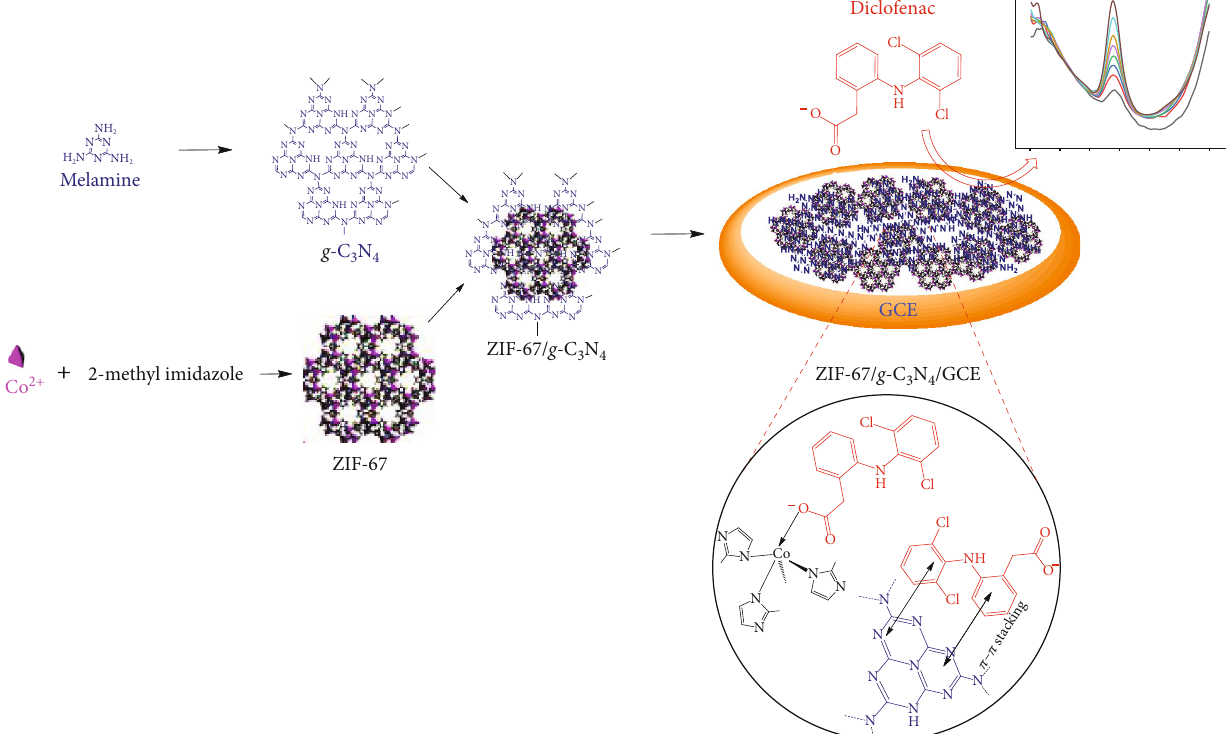
Scheme 2: Schematic illustration of the formation of ZIF-67/ g -C